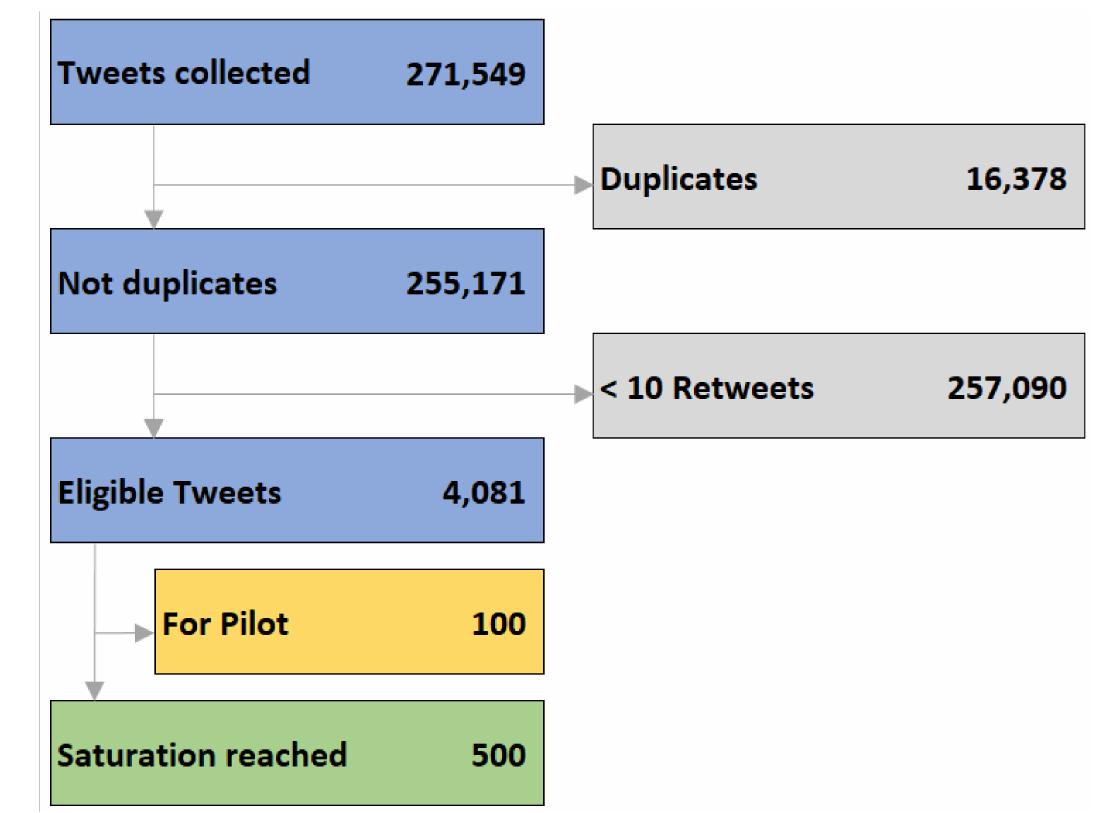
Figure A2. Flowchart of COVID-19-related Tweets of toilet paper posts between 29 February 2020 and 29 March 2020 from collection to inclusion. Table A2. Keywords identified in Sentimental Analysis. Keywords